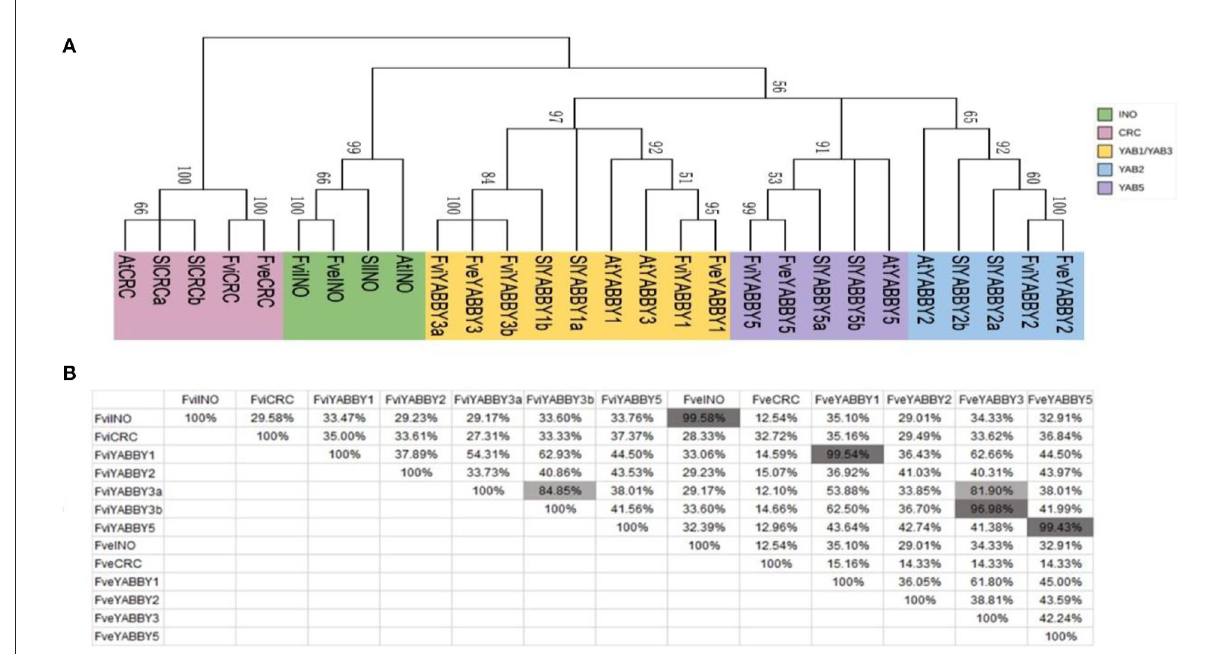
FIGURE5 Homology analysis of YABBY family members in Fragaria viridis and Fragaria vesca. (A) Phylogenetic tree of YABBY family members in F. viridis and F. vesca . (B) Amino acid similarity between YABBY family members in F. viridis and F. vesca